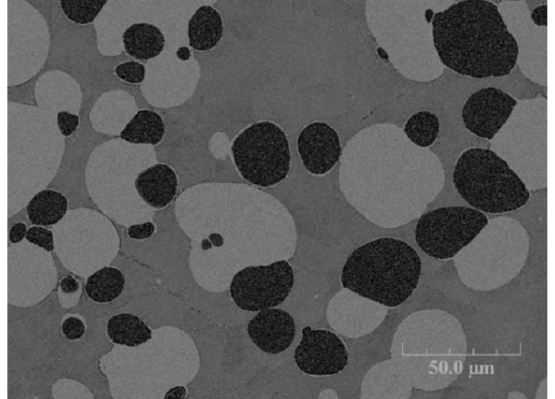
Figure 22. Backscattered SEM micrographs showing water-quenched microstructures of Zn-5 wt% Al alloy at initial stage of eutectic solidification, the alloy was continuously sheared at 4082 s − 1 , cooled at 1 °C/min from 385 °C to 380.6 °C, and times after reaching 380.6 °C for 120 s (white: Zn phase, black: Al phase) [218]. Reprinted under the Creative Commons Attribution License (CC- BY) 4.0.